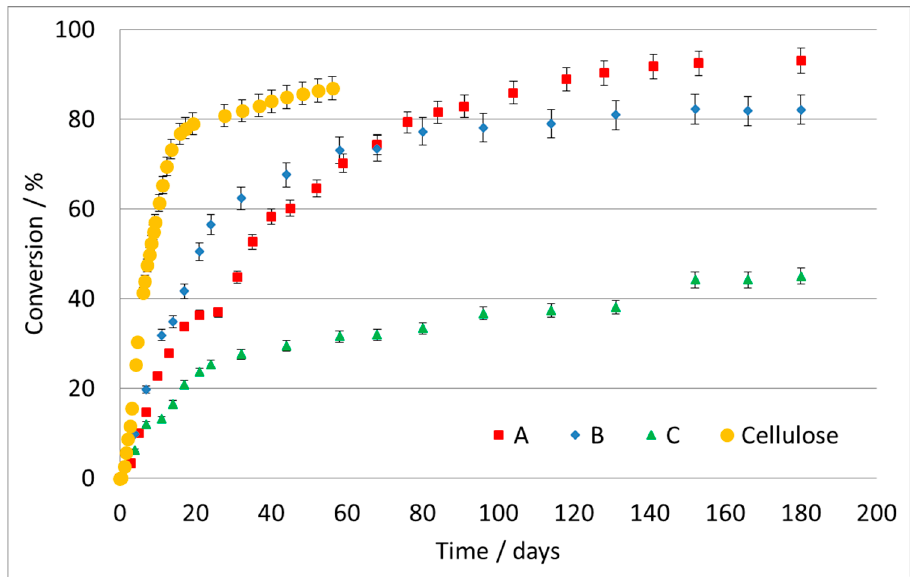
Figure 1. Conversion (%) of the three commercial samples and reference cellulose as a function of time.